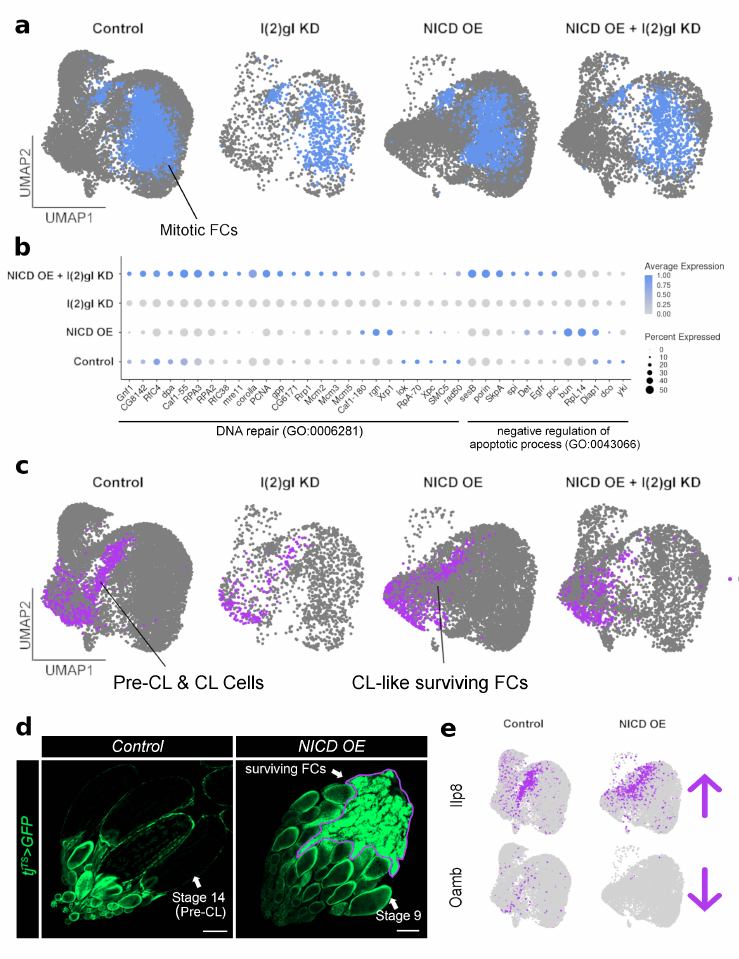
Figure 7. Single-cell RNA sequencing reveals cell-type-specific expression patterns of survival-related genes following NICD overexpression. ( a ) UMAP plot of all four genotypes with the mitotic follicle cells (FCs) specifically highlighted in blue. These cells were subset for analysis in ( b ). ( b ) Dot plot of mitotic FC cluster split between each genotype. DNA repair (GO:0006281) and negative regulation of apoptotic process (GO:0043066) genes are grouped by GO term. NICD OE + l(2)gl KD cells have a higher expression of these survival-related genes compared to l(2)gl KD. Some genes, like rgn , Xrp1 , bun , RpL14 , and Diap1 are more highly expressed in NICD OE cells. ( c ) To more carefully examine surviving cells in NICD OE genotype, the Pre-CL and CL Cells cluster is highlighted in purple and subset for analysis in ( e ). ( d ) Confocal images of control and NICD OE ovaries. Unlike control oogenesis, NICD OE blocks development at stage 9, where the germline undergoes apoptosis and the follicle cells survive in the posterior ovary. Scale bar = 100 µ m. ( e ) Feature plots showing that like corpus luteum (CL) cells in the control sample, the surviving NICD OE follicle cells have upregulated the insulin pathway gene, Ilp8 , expression. However, unlike true CL cells, CL-like surviving cells lack expression of the ovulation gene, Oamb